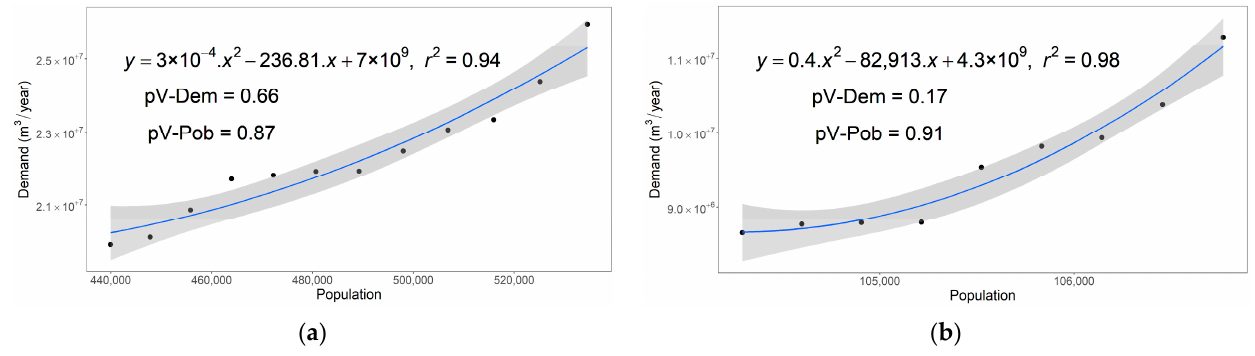
Figure 8. Relationship between water demand and inhabitants, ( a ) Sub-basin 1 and ( b ) Sub-basin 4.